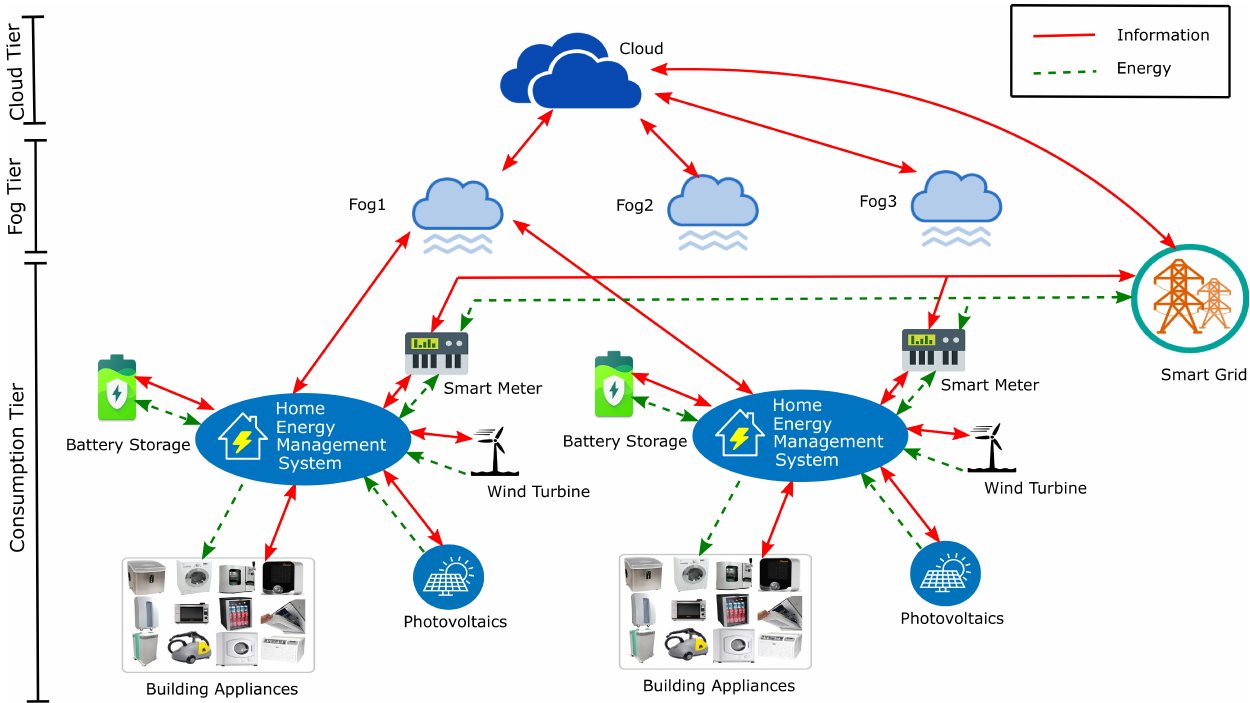
Figure 2. Fog-enabled system architecture of a smart